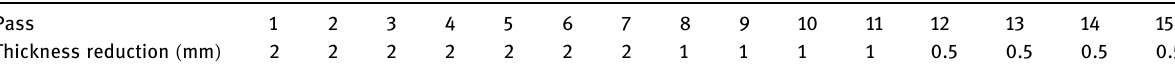
Table 1: Rolling thickness reduction in each pass Pass